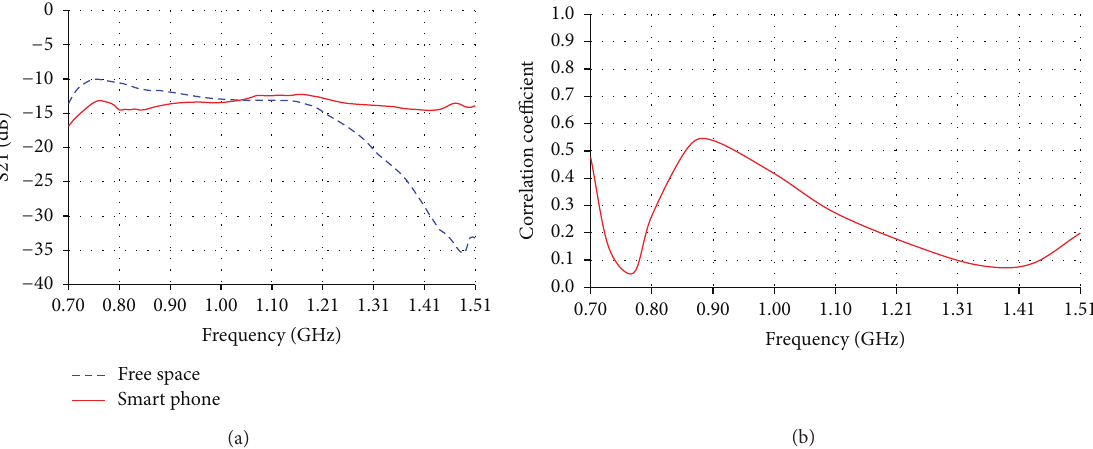
Figure 11: (a) Measured isolation (S21) and (b) correlation coefficient between primary and diversity MIMO low band antennas.